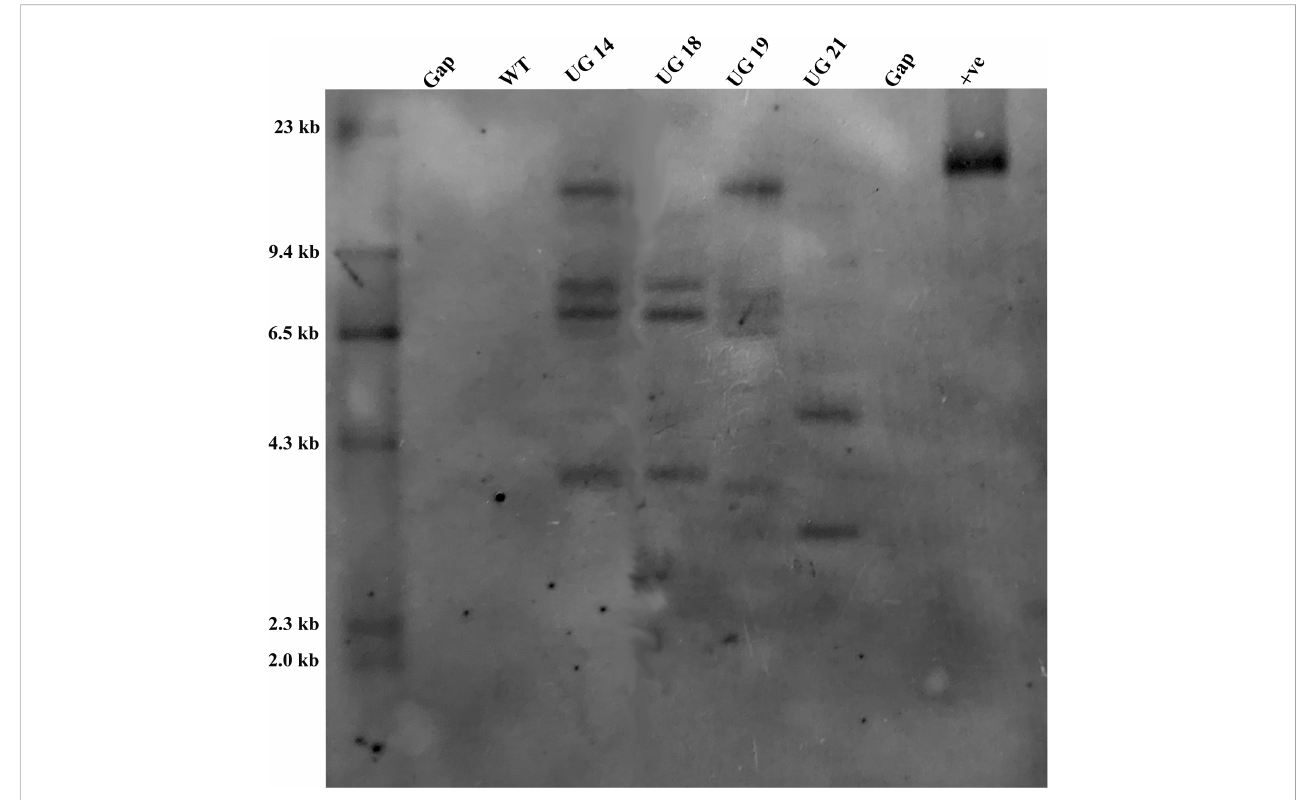
FIGURE 6 Southern blot analysis of the UGPase RNAi transgenic potato lines of KC4. Lanes: WT, wild type control; UG14, UG18, UG19, UG21 represent transgenic potato lines; +ve, positive